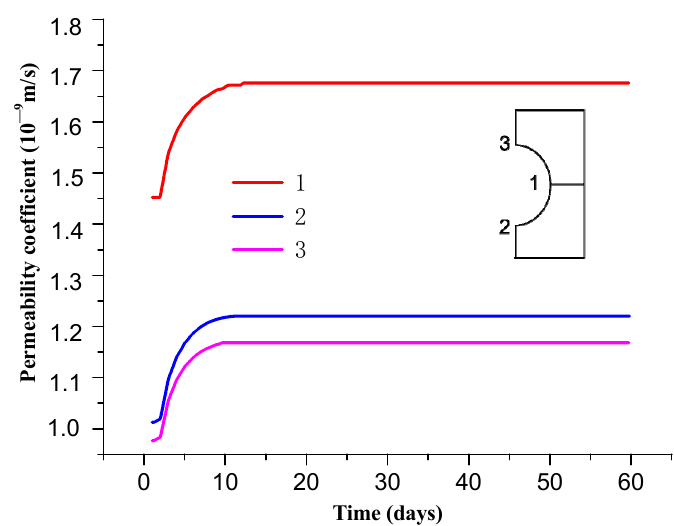
Figure 12. Variation curve of permeability coefficient of surrounding rock over time.